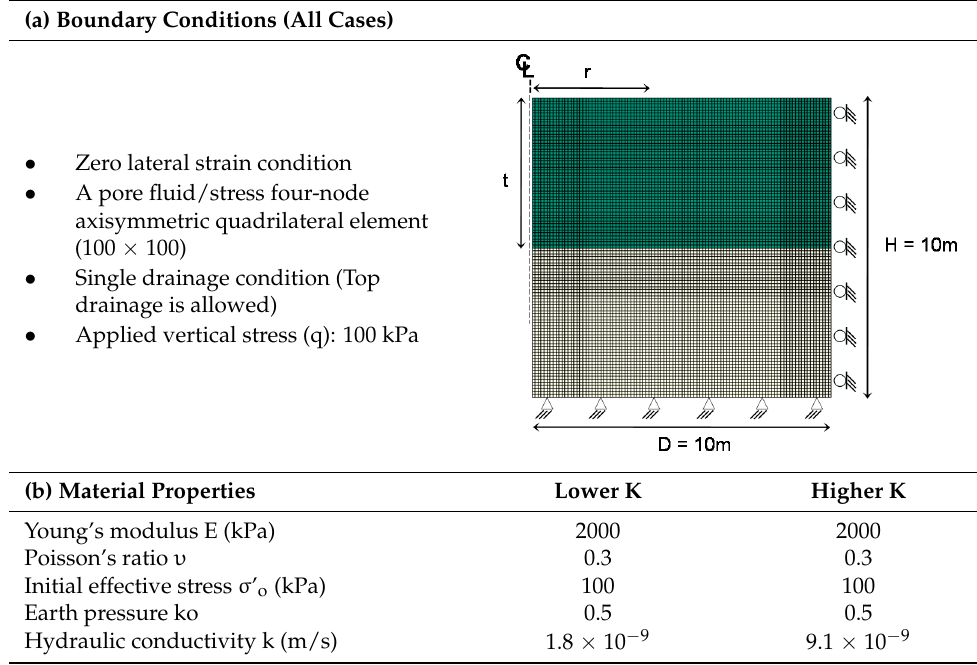
Table 1. Numerical study in binary mixture: ( a ) Boundary conditions; ( b ) Selected material properties.